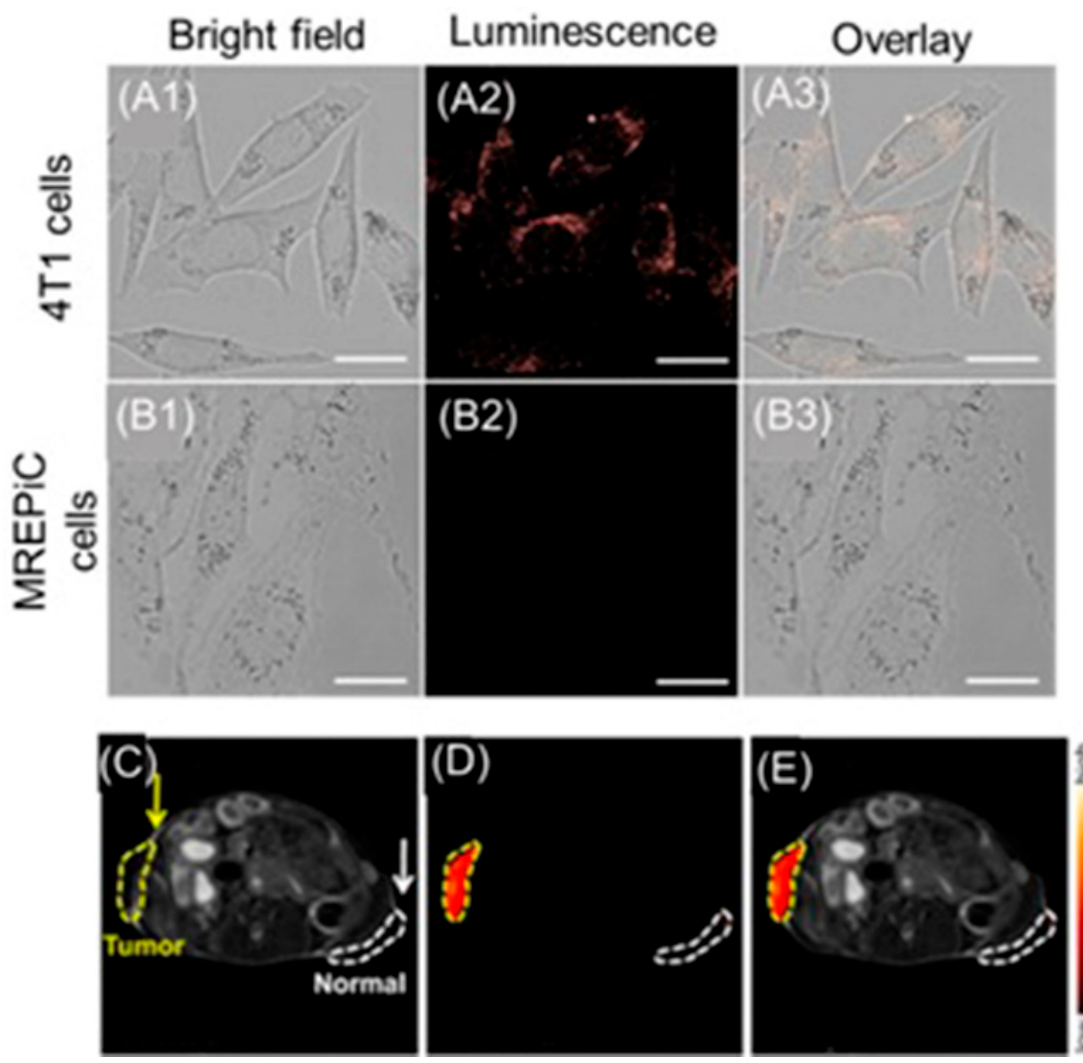
Figure 32. In vitro studies of hypoxic 4T1 cells, normoxic MREPiC cells, and in vivo studies of 4T1 tumor-bearing mice. Confocal laser scanning microscopy fluorescence images of ( A1 – A3 ) hypoxic 4T1 cells and ( B1 – B3 ) MREPiC normoxic cells incubated with nanoprobe for 4 h (400 µ g mL − 1 ). The excitation wavelength was 405 nm. All of the scale bars = 25 µ m. Hypoxic cells incubated with the nanoprobe exhibited intense luminescence compared to normoxic cells. ( C ) 1 H-, ( D ) 19 F-MRI, and ( E ) overlay images of 4T1 tumor-bearing mice after intratumoral injection of the nanoprobe (20 mg mL − 1 , 150 µ L). The same dose of nanoprobe was subcutaneously injected into normal tissue for comparison (white dashed lines denote the area). Yellow dashed lines mark the tumor site. Adapted with permission from Jiang, L.; Zhou, Q.; Mu, K.; Xie, H.; Zhu, Y.; Zhu, W.; Zhao, Y.; Xu, H.; Yang, X. pH/temperature-sensitive magnetic nanogels conjugated with Cy5.5-labeled lactoferrin for MR and fluorescence imaging of glioma in rats. Biomaterials , 2013 , 34 , 7418–7428. Copyright 2013 American Chemical Society